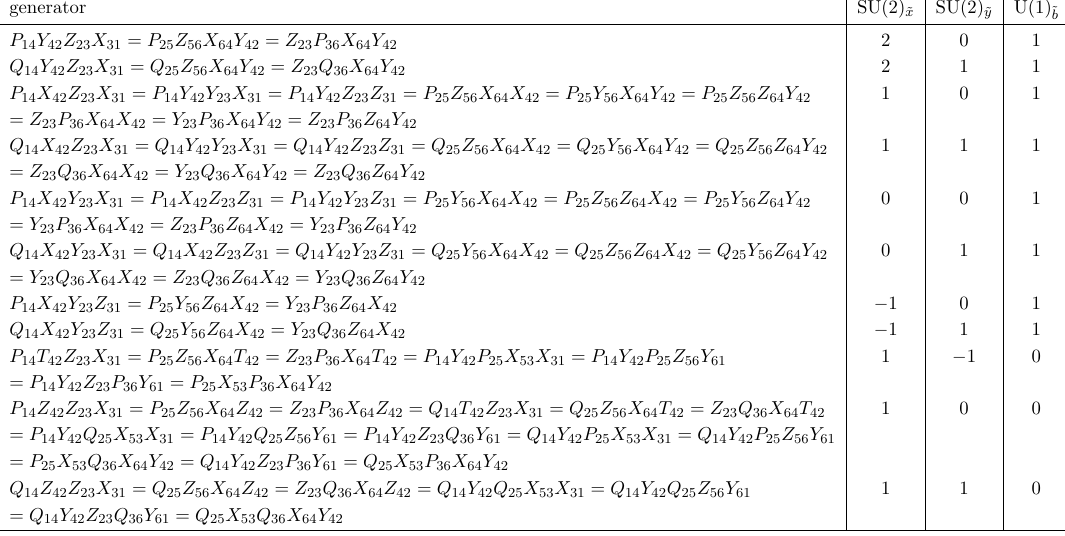
Table 17 . The generators in terms of bifundamental chiral fields for Model 4 (Part 1) .